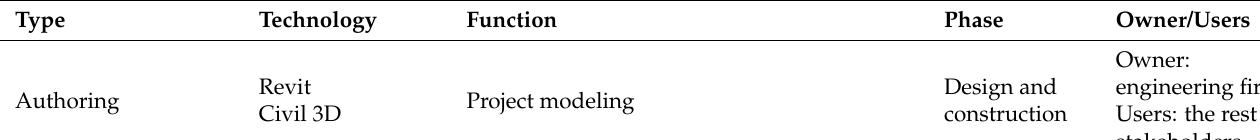
Table 1. Technological applications in project case